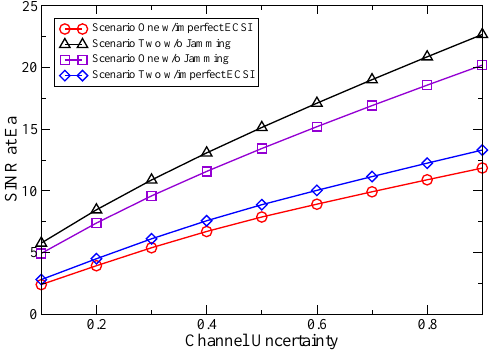
Figure 4. SINR at Ea vs. channel uncertainty.